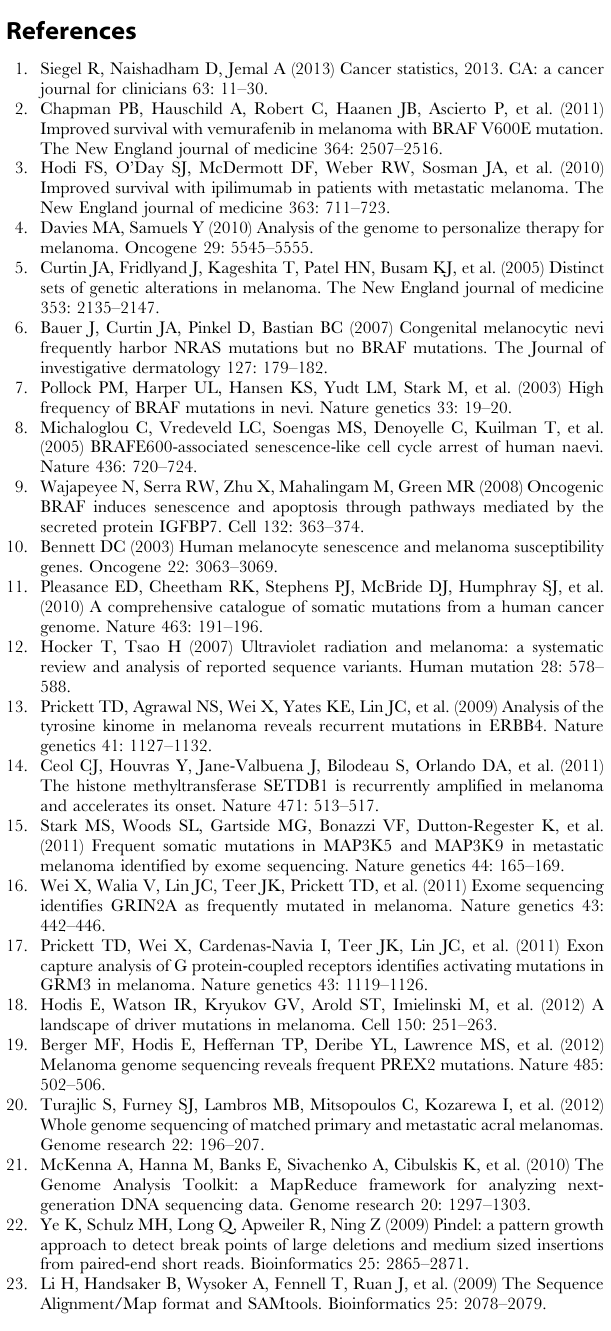
MEL5 Pancreas sample. (d) Readcounts for point mutations pictured in Figure 6, MEL13 Lung sample. (e)Readcounts for point mutations pictured in Figure 6, MEL13 Chest Wall sample.(f) Readcounts for point mutations pictured in Figure 6, MEL5 sample.(g) Readcounts for point mutations pictured in Figure 6, MEL13 sample: See separate.xlsx file. Table S14 in File S2 : Nonsynonymous mutations in the four metastases samples of MEL167 along with the readcounts and annotation: See separate.xlsx file.